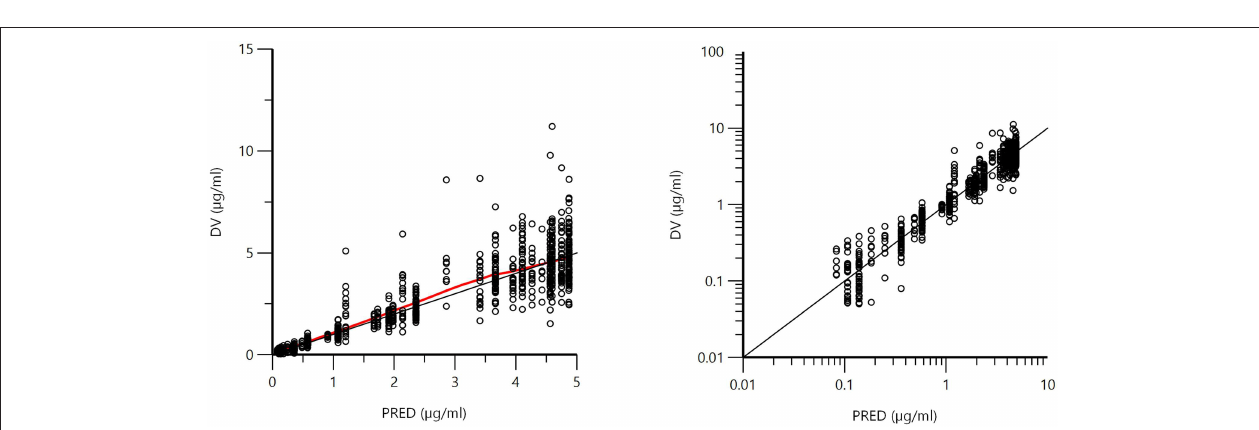
FIGURE 1 | Semi-logarithmic spaghetti plot for 50 calves sorted by sources (left) (Red = A, Gray = B, Blue = C) or by formulation (right) (Black = Nuflor ® , Red = generic). Visual inspection of the plots does not suggest major differences either between the three sources of data or for the two formulations, as seen from the intermingling of the curves.